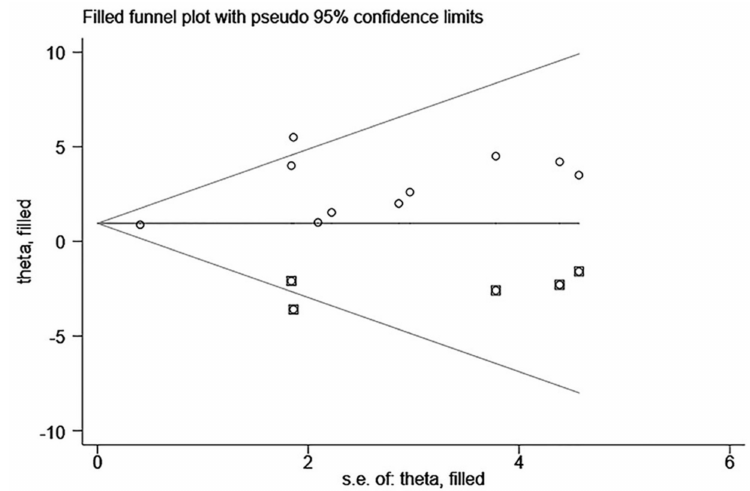
Figure 9. O: previous studies; (cid:3) : filled studies. A funnel plot with trim and fill for the effect size of